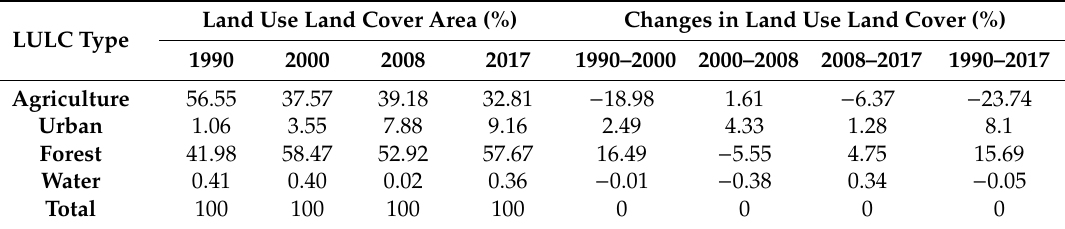
Table 3. The area percentage of land use land cover from the 1990–2017 period in the Guangyuan